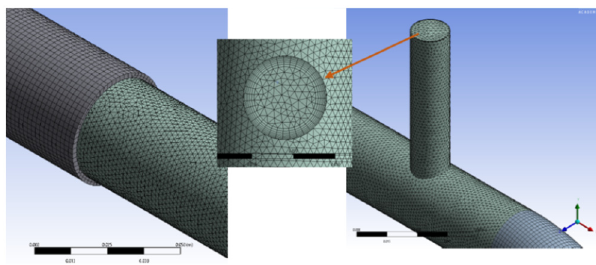
Fig. 5. DYNASTY mesh: closeup at inflation layers applied on water